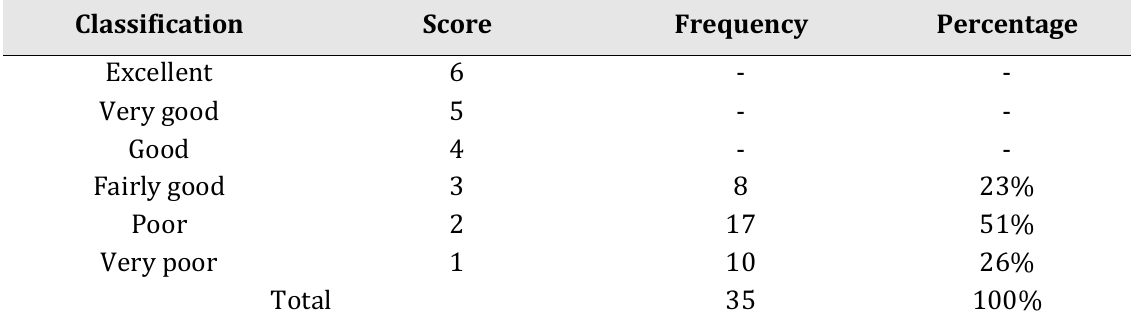
Table 7. Rate Percentage Point of Students’ Accuracy in Pre -test